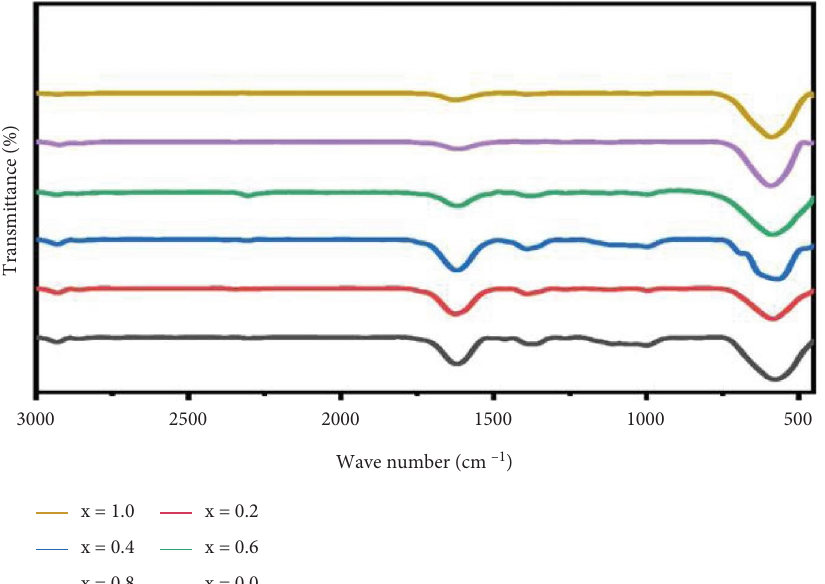
Figure 9: FTIR spectra of the prepared Co